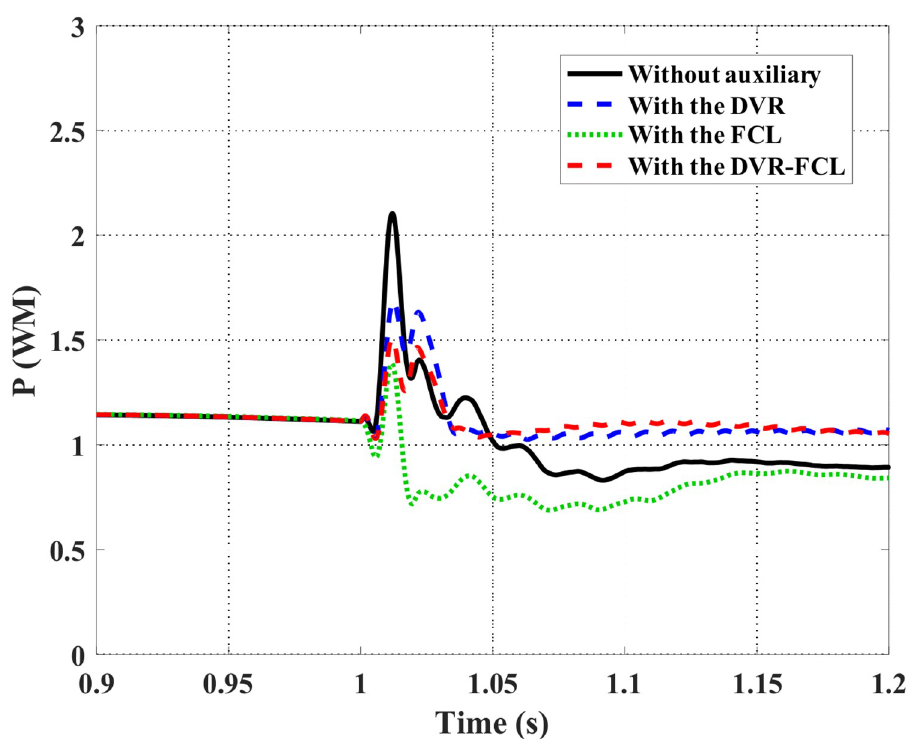
Fig 17. Active power of the DFIG subject to the asymmetrical fault.